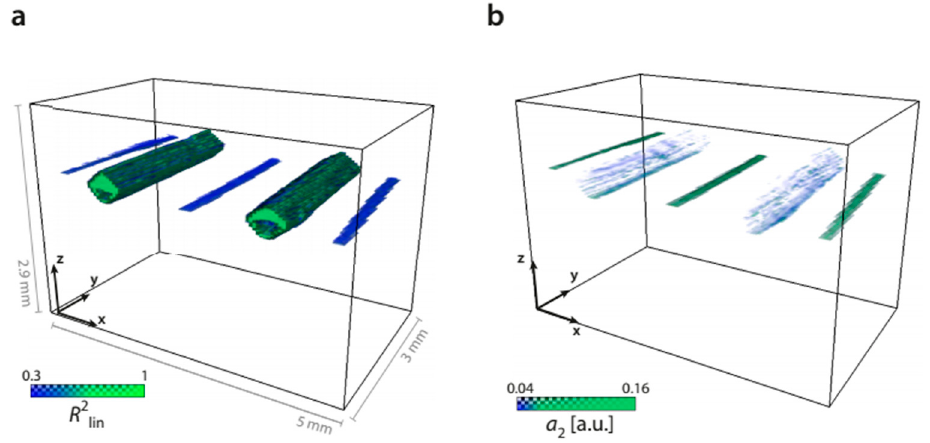
Figure 8. 3D image of ( a ) R 2 (Method I, linear regression) and of ( b ) a 2 (Method II, polynomial fit) Figure 8. 3D image of ( a ) (cid:1844) (cid:3039)(cid:3036)(cid:3041)(cid:2870) ( Method I, linear regression) and of ( b ) (cid:1853) (cid:2870) (Method II, polynomial fit) Figure 8. 3D image of ( a ) (cid:1844) (cid:3039)(cid:3036)(cid:3041)(cid:2870) ( Method I, linear regression) and of ( b ) (cid:1853) (cid:2870) (Method II, polynomial fit) lin using N = 4 images, all acquired with fluence values below the using N = 4 images, all acquired with fluence values below the MPE. using N = 4 images, all acquired with fluence values below the MPE.